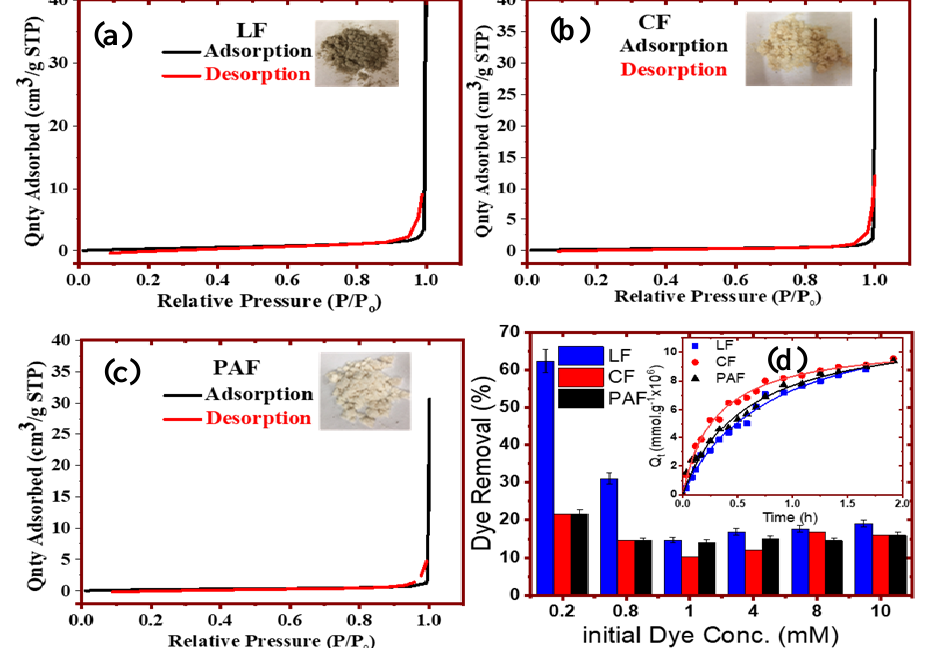
Figure 5. Adsorption properties for linen fiber (LF) materials and its treated forms (CF and PAF): ( a – c ) nitrogen gas isotherms, and ( d ) methylene blue (MB) dye removal at equilibrium and kinetic conditions (see inset).